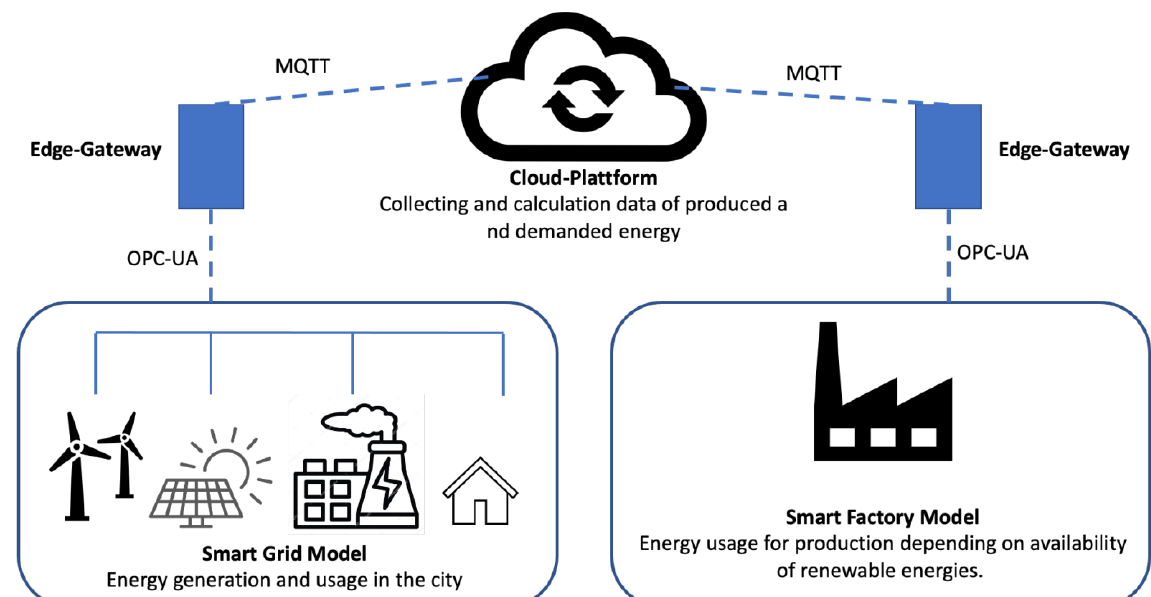
Figure 1 . The demand response